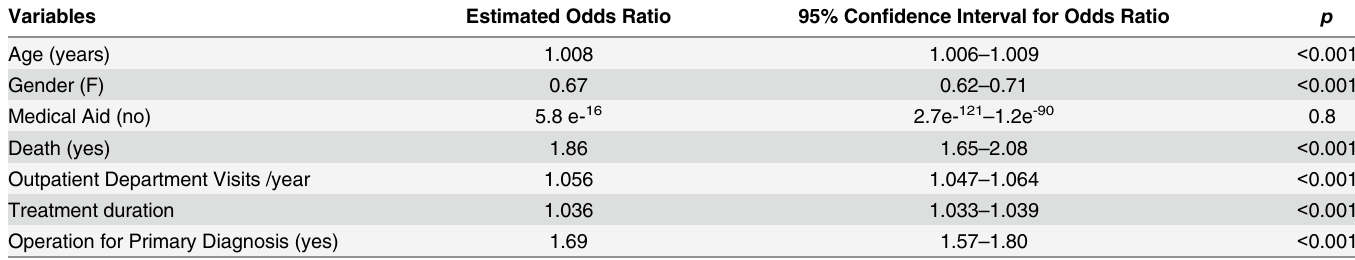
Table 2. Independent risk factors of frequent ED